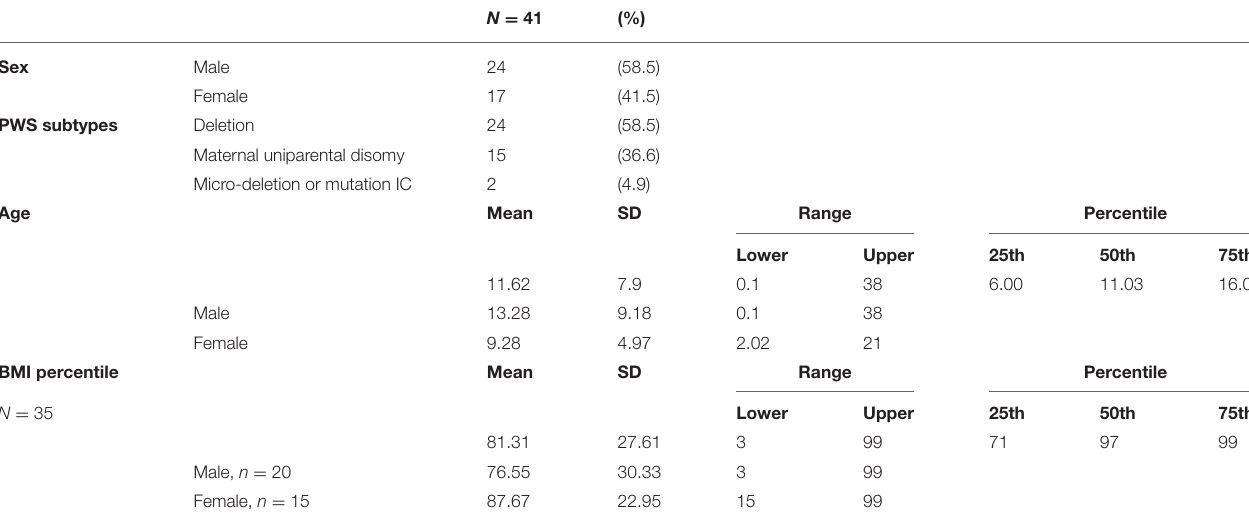
TABLE 2 | Sociodemographic and clinic profile of PWS children, adolescents, and